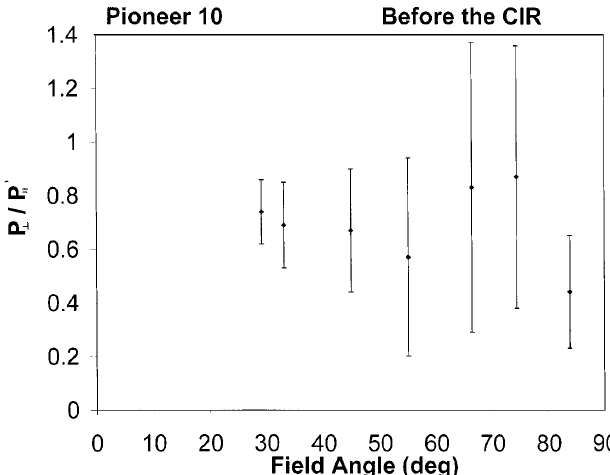
Fig. 2. An example of power spectra perpendicular and quasi-parallel to the mean field inside the CIR